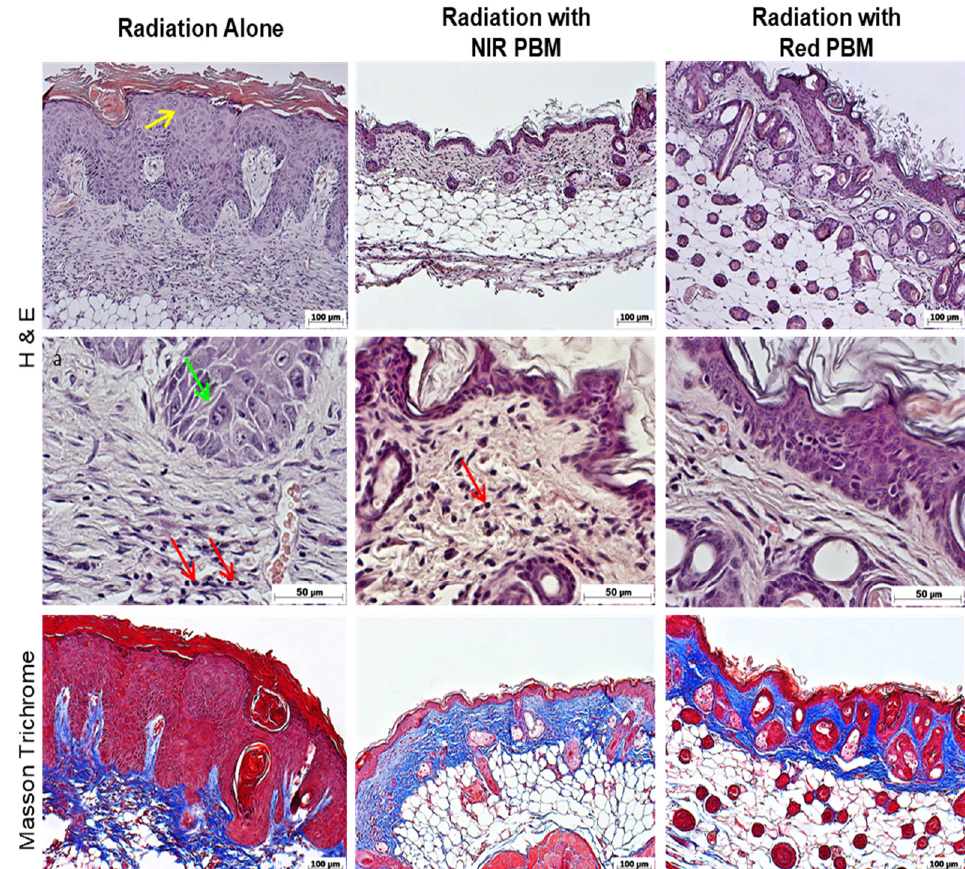
Figure 6. Histological analysis with H&E and Masson Trichrome staining of skin overlying the implanted 125 I seed at 42 days. The left panel shows tissues from the radiation alone, the middle depicts the radiation with NIR treatments, and the right panel shows radiation with red PBM-treated group. The yellow arrows highlight the hyperkeratotic regions with mitotic figures (green arrow), indicating cell proliferation in the spinous zone. The red arrows highlight the inflammatory cells infiltrating the connective tissue.